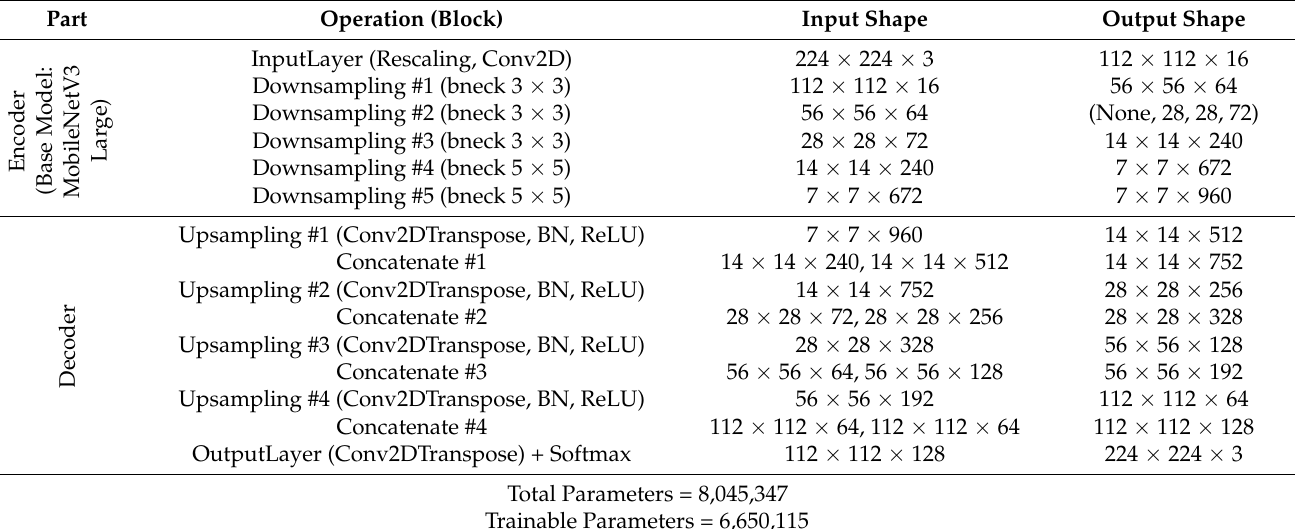
Table 4. Details of layers and number of parameters in the proposed